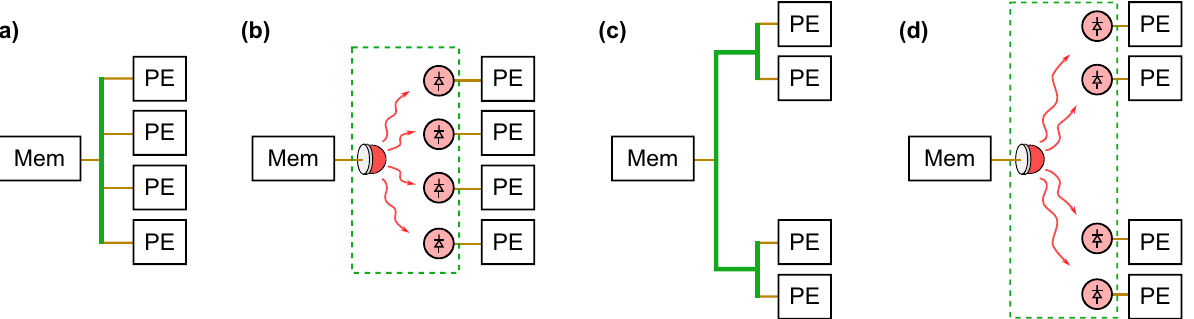
Figure 6. Fan-out of one bit from memory (Mem) to multiple processing elements (PEs). ( a ) Fan-out by electrical wire to a row of PEs in a monolithic chip. ( b ) DONN equivalent of monolithic chip, where green wire is replaced by optical paths. ( c ) Fan-out by electrical wire to blocks of PEs divided into chiplets, or separated by memory and logic. ( d ) DONN equivalent of fan-out to PEs in multiple blocks [energetically equivalent to ( b )].